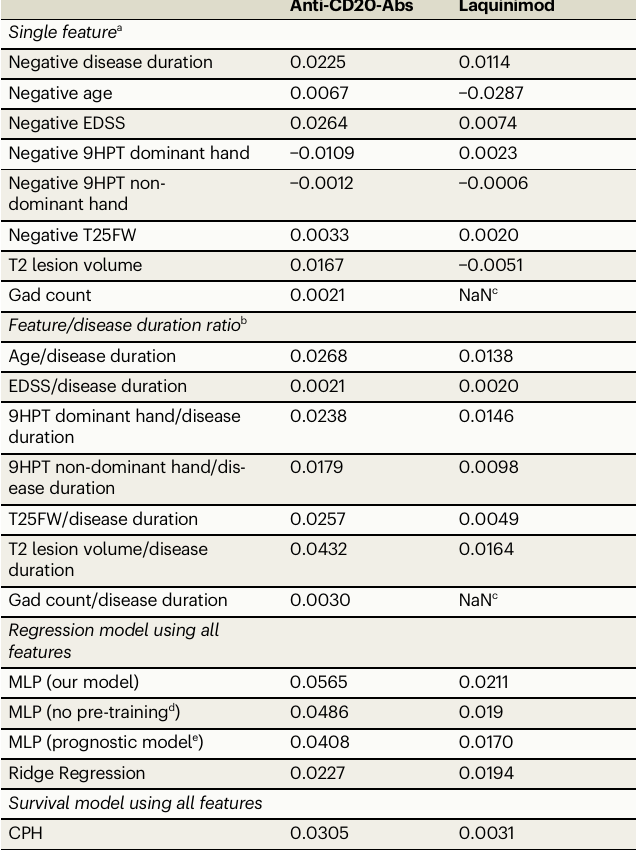
Table 3 | Comparison of model performance (measured by AD wabc ) on the held-out test set of patients from ORATORIO and OLYMPUS (anti-CD20-Abs), and on the held-out dataset from ARPEGGIO